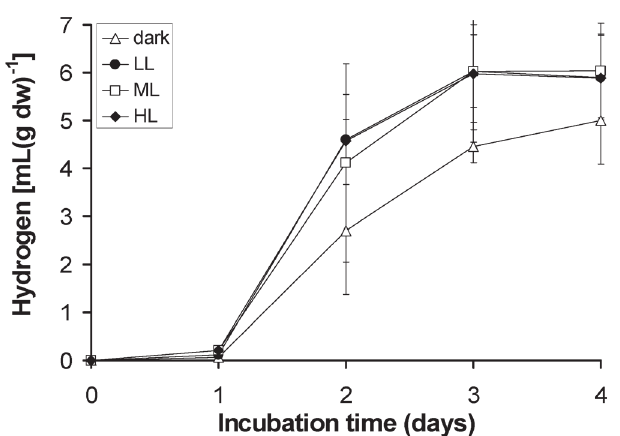
Fig 6. Kinetic of hydrogen production of the lichen Pleurosticta acetabulum in several light intensities.